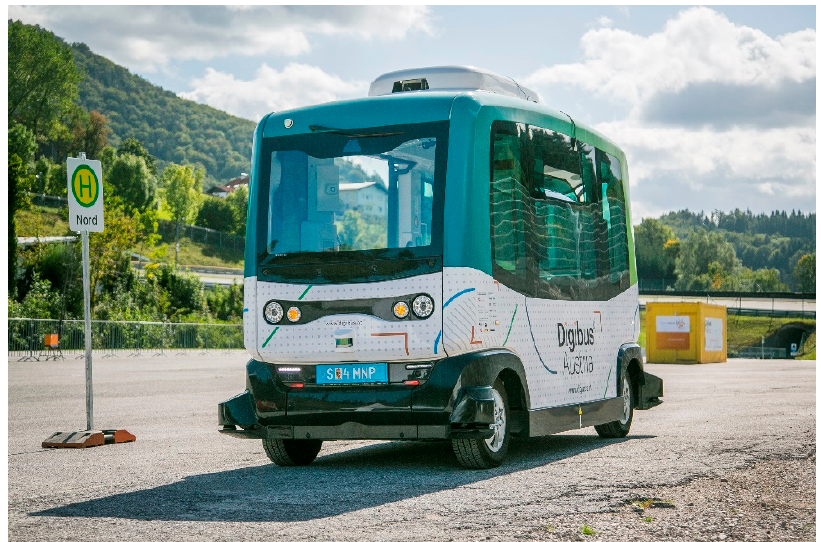
Figure 1. The automated shuttle at a bus stop during test rides (picture copyright: Salzburg Re- search/wildbild/Rohrer).